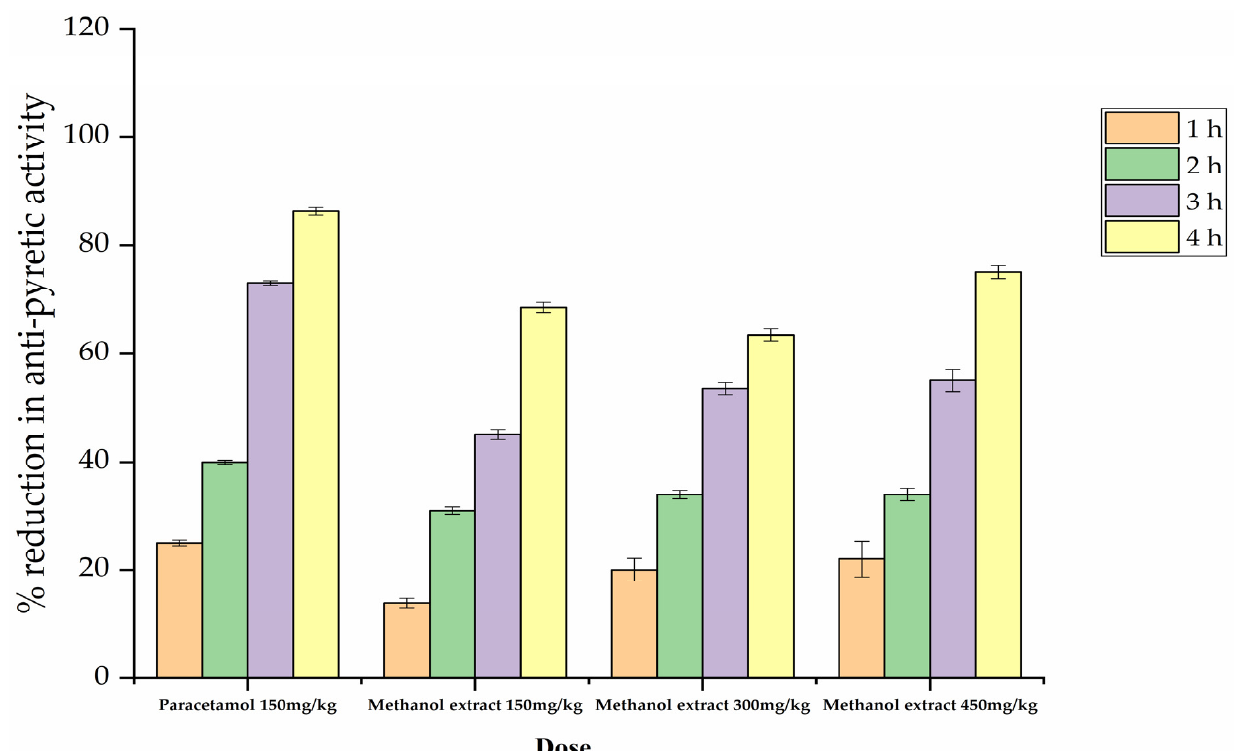
Figure 2. Percentage (%) reduction of antipyretic potential of different dose of methanolic extracts after 1 h, 2 h, 3 h and 4 h, respectively.